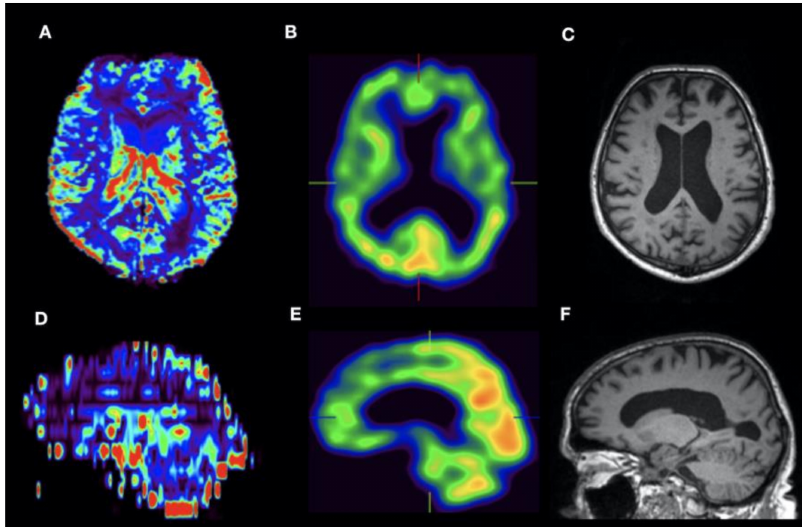
Figure 4. Male with FTD, 69 y, Mini-Mental-Status-Test score 30. DSC Perfusion ( A , axial orientation; D , sagittal orientation rCBVc map) shows typical pattern of frontal cortical hypoperfusion. Correlation with HMPAO-SPECT ( B , E ) and the anatomical dataset with ventricular widening as sign of atrophy (T1w in C and F ).